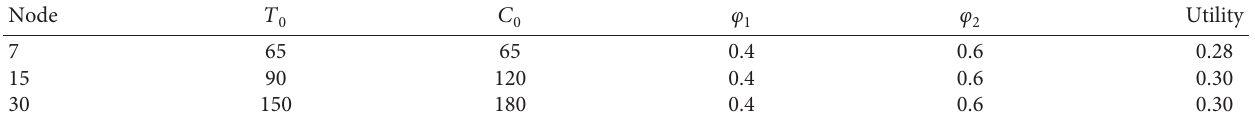
Table 9: Comparison of RU and EUM ( T